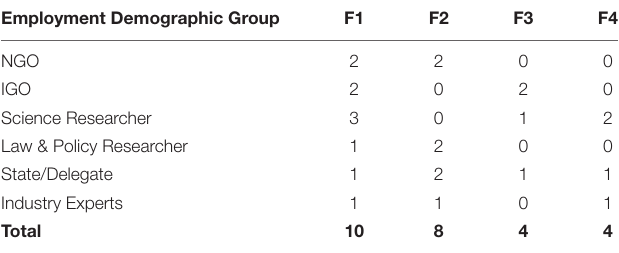
TABLE 1 | Composition of factors (F), illustrating the employment demographic group of factor exemplars and the total number of exemplars per factor (in bold). Employment Demographic